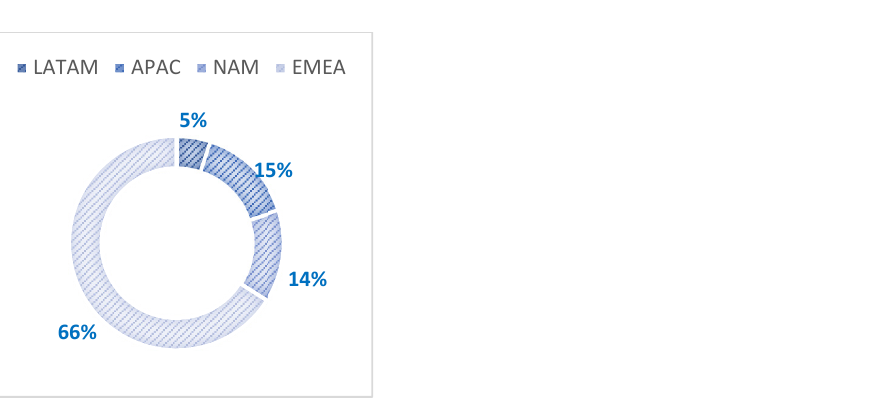
Figure 4. Global Sustainable Bond Issuance Set to Surpass USD 1.5 Trillion in 2022 (Shapiro and Mitchell 2022).